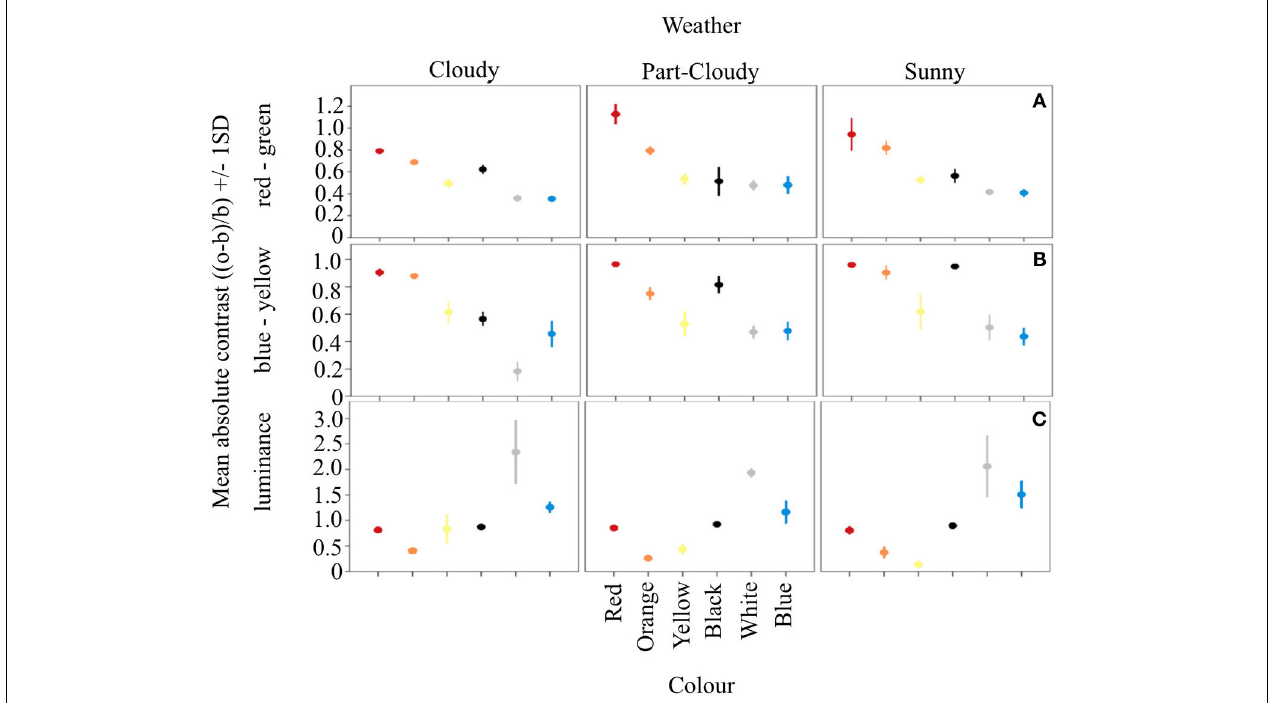
FIGURE 1 | Mean absolute contrast and Standard Deviation (SD) of the six color signals analyzed. Vertical panels show the variation of these signals on the different weather conditions, while horizontal panels show the opponent channel activation of the three systems analyzed. Panel (A) shows how in the RG system the longwave colors are more contrasting. Similar